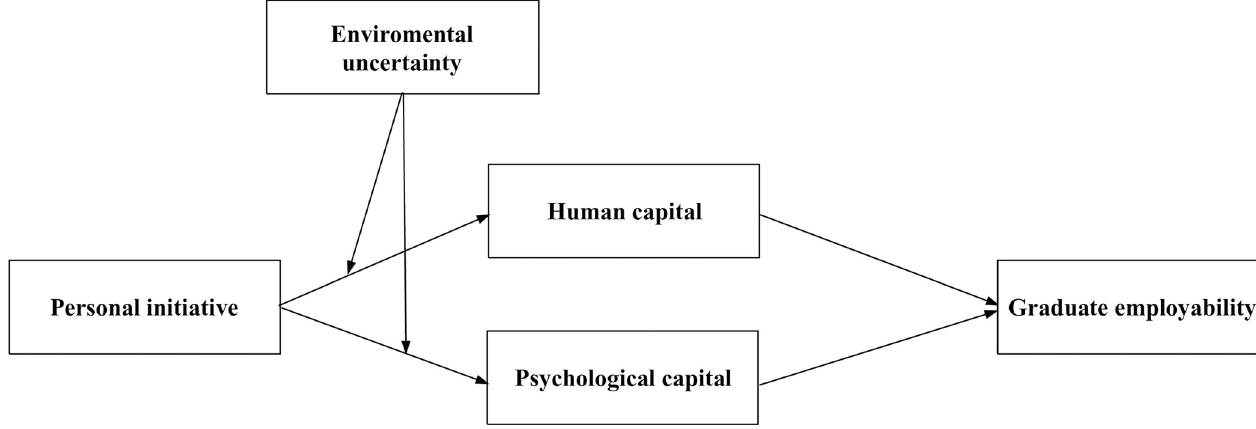
Fig 1. The dual-path model of personal initiative affecting graduate